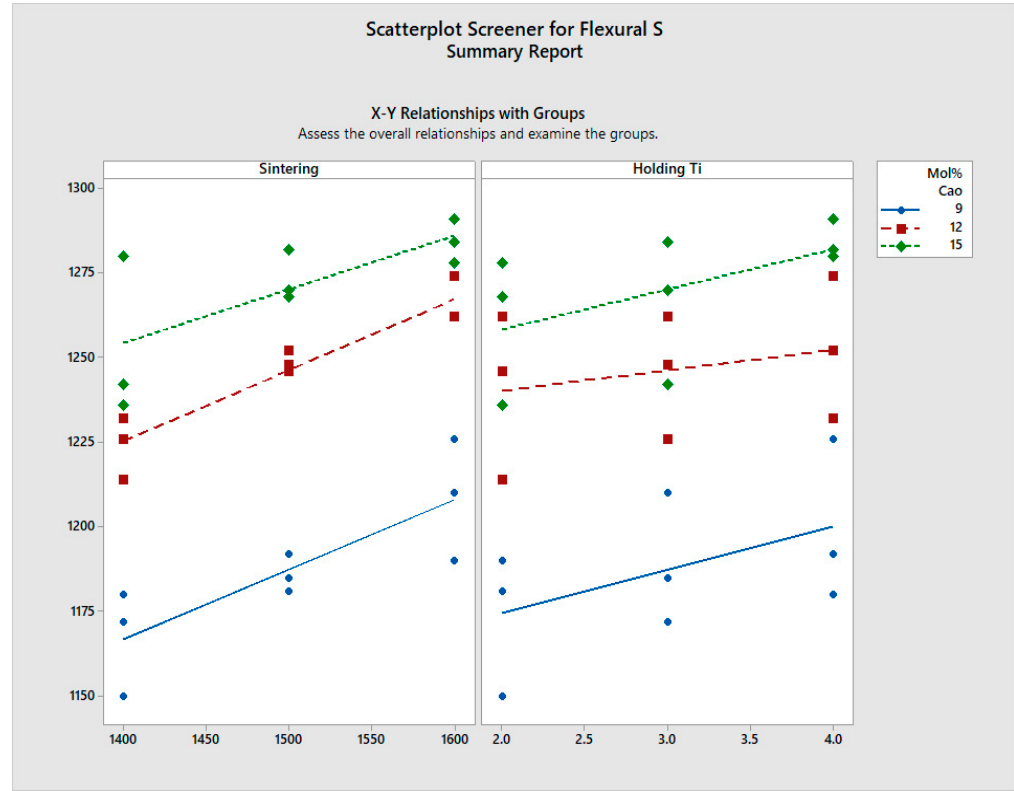
Figure 7. Effect of composition, sintering temperature, and holding time on flexural strength.